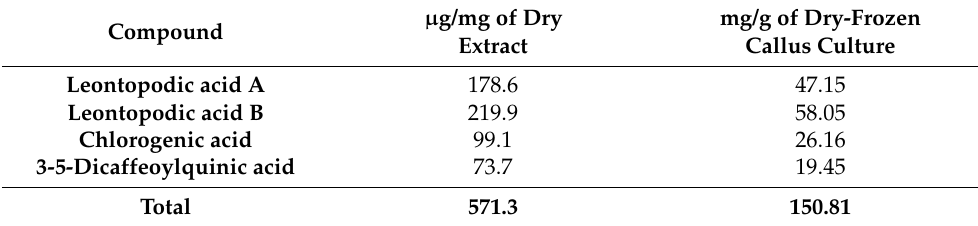
Table 2. Quantitative determination of the major